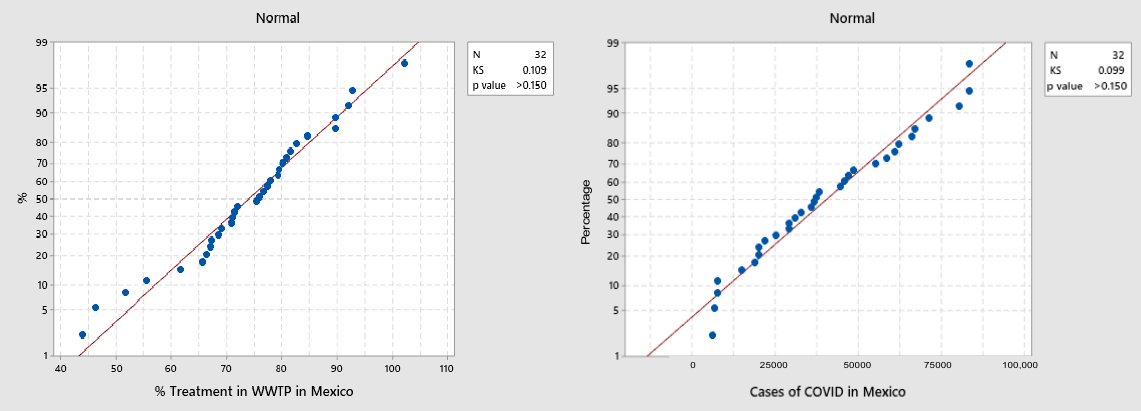
Figure 3. Kolmogorov–Smirnov normality test chart.